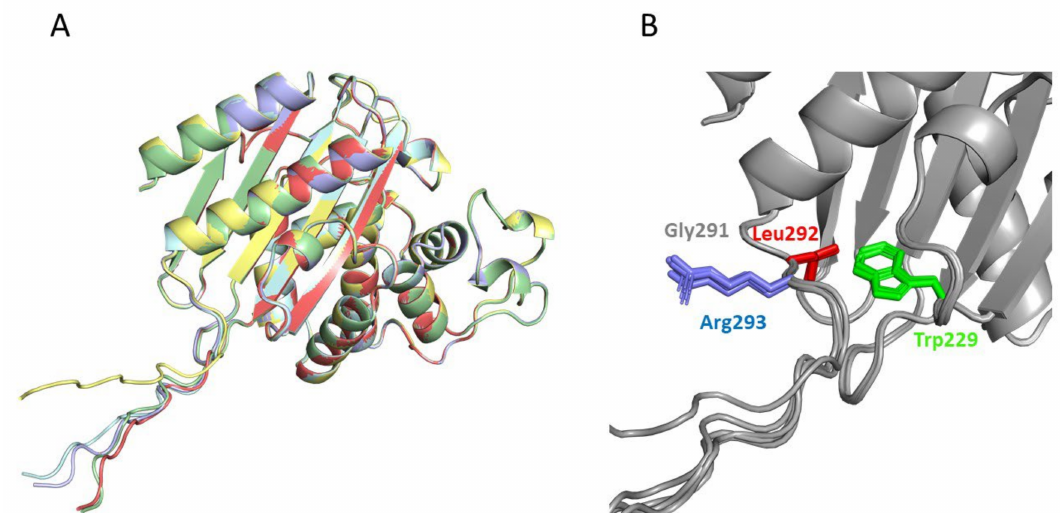
Figure 5. Prediction of the structure of the best Kemp eliminase obtained in this work by the program AlphaFold2 [39]. The prediction was carried out with a sequence that had a tryptophan at position 229, i.e., the function-generating W229D mutation was omitted. The reason for this was that the tryptophan at position 229 occupied a position close to that of the transition structure in the active Kemp eliminase (Figure 2A). Therefore, interactions with W229 in the predicted structure may conceivably correspond to interactions with the transition state that affects catalysis in the W229D variants. The top five predicted structures ( A ) are very close to the experimental structures shown in Figure 2, although the additional GLRG 3 SLEH 6 polypeptide appears mostly extended and exposed to the solvent. However, a blow-up of the de novo active site region ( B ) reveals an interaction between the leucine of the polypeptide and the tryptophan at position 229 that could correspond to a kinetically relevant interaction with the transition state in the Kemp